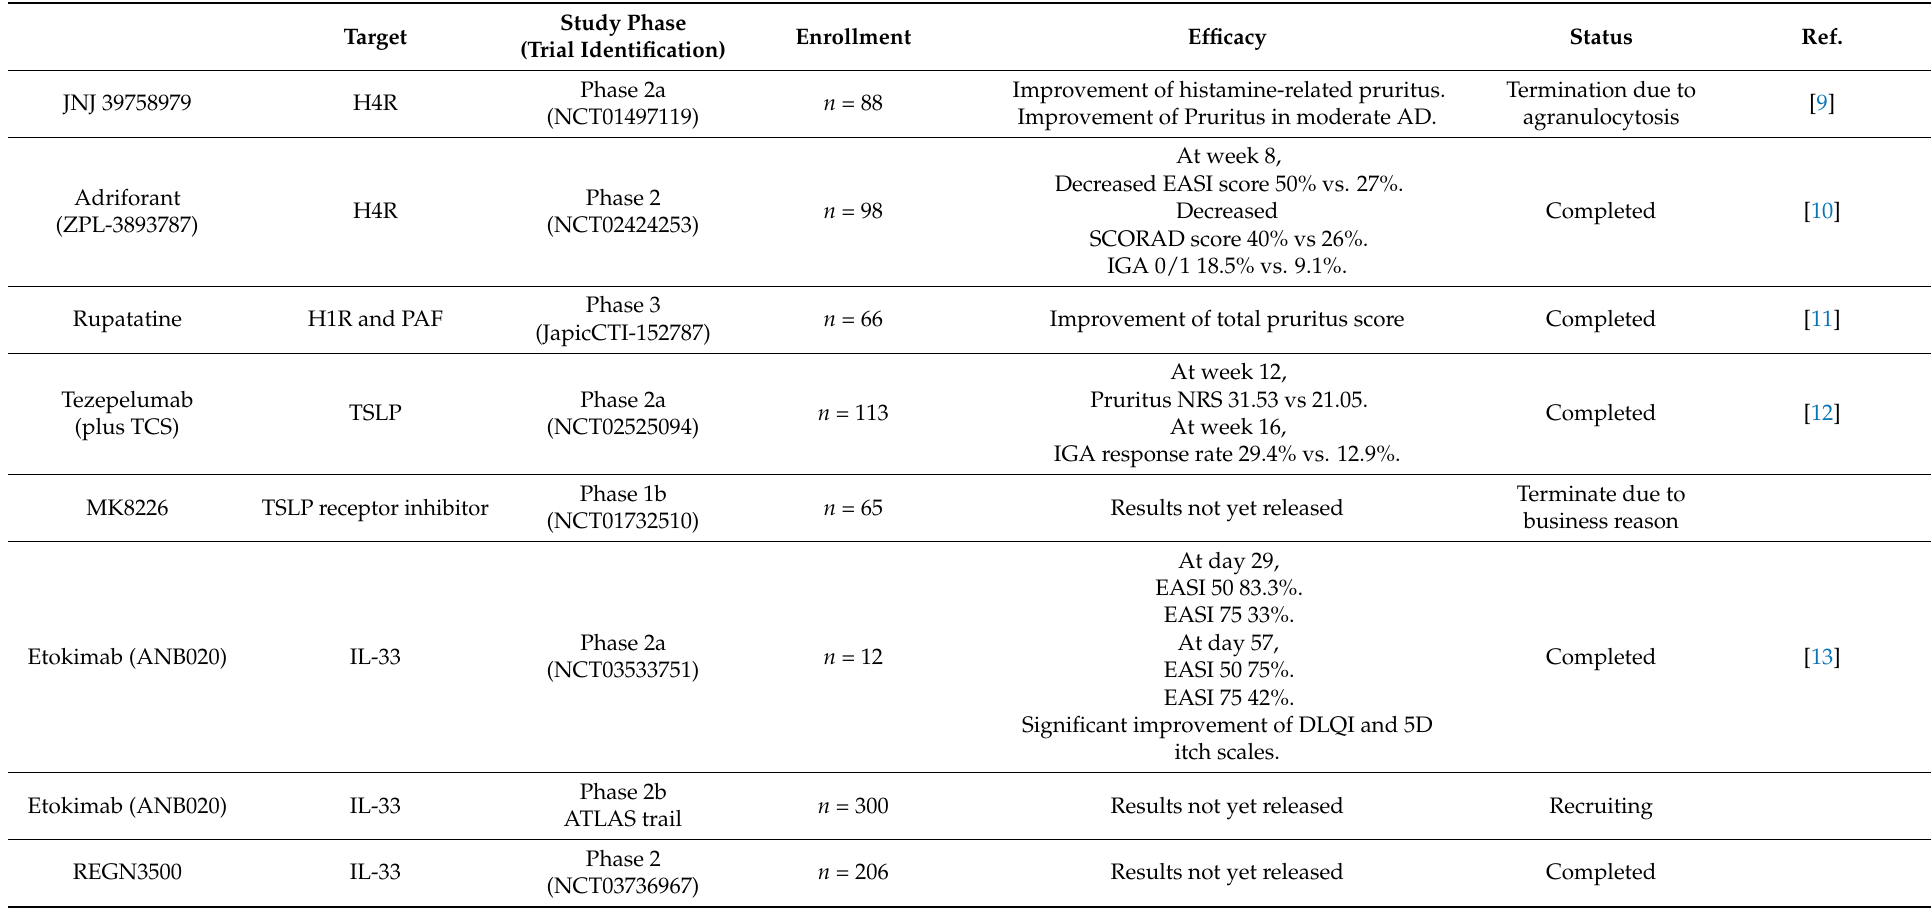
Table 1. Potential experimental targeted biologics against pruritogens in